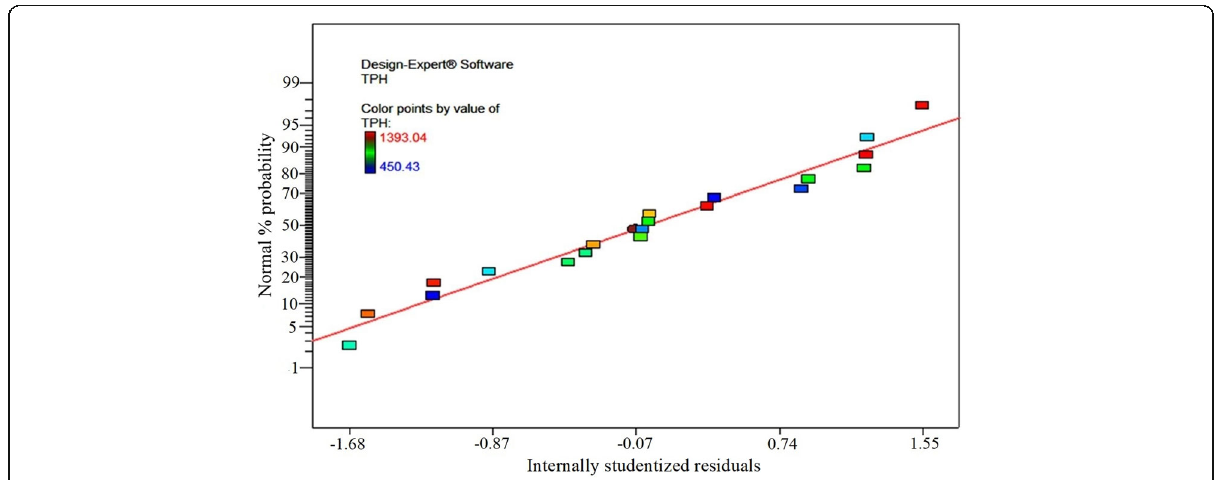
Fig. 5 Normal probability plot of studentized residuals for